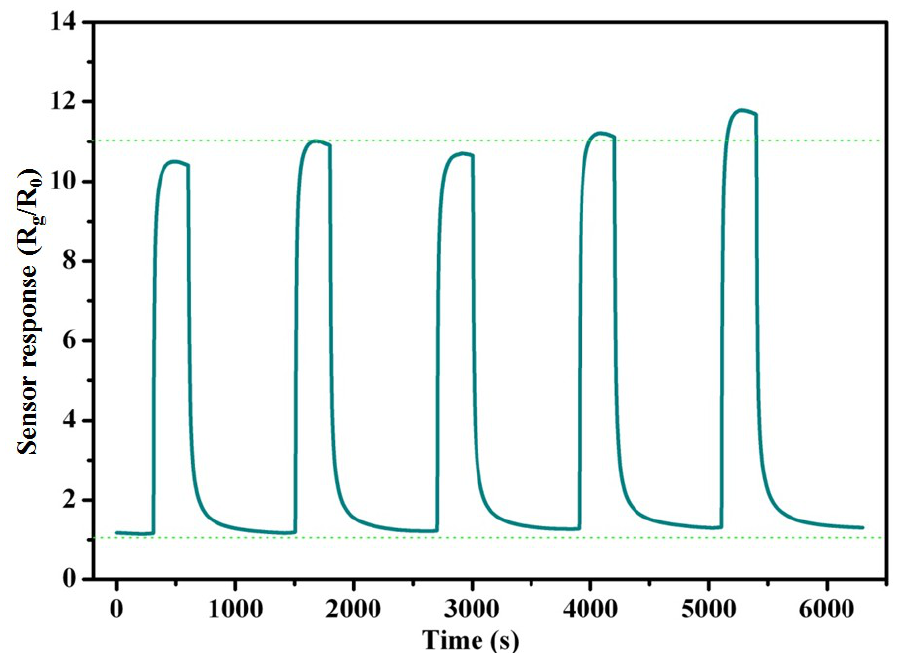
Figure 8. The repeatability curve of TiO 2 @PANI samples with m (TiO 2 )/m (Ani) = 2 to 50 ppm NH 3 gas at room temperature, and the green dash line (below) is the baseline and the upper green dash line represents the average value of the sensor responses.